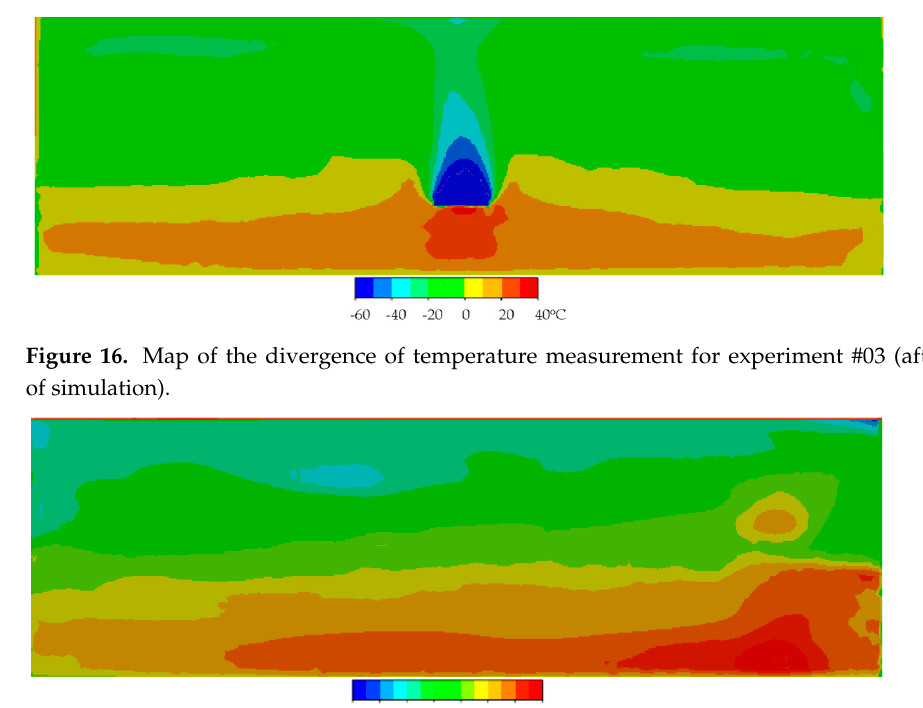
Figure 17. Map of the divergence of temperature measurement for experiment #17 (after 225 s of simulation).